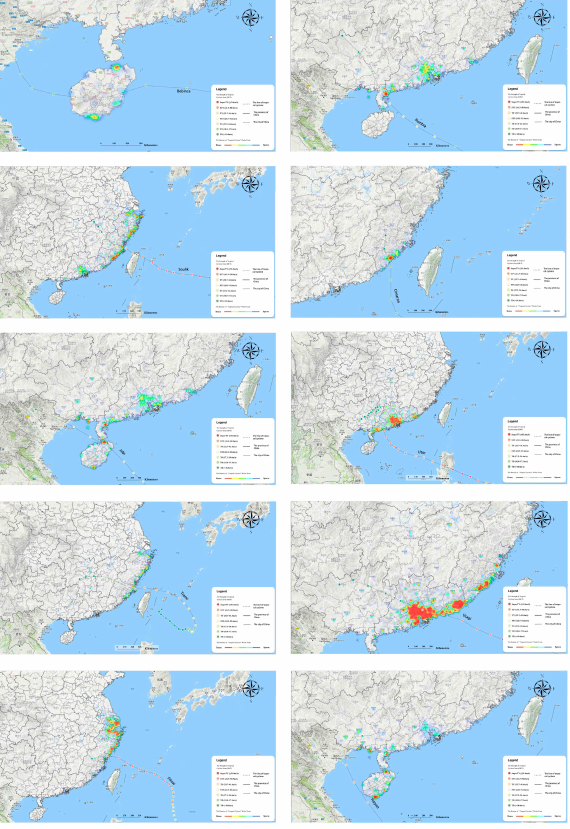
Figure 2. The thermodynamic diagram of tropical cyclone related Weibo activity in affected